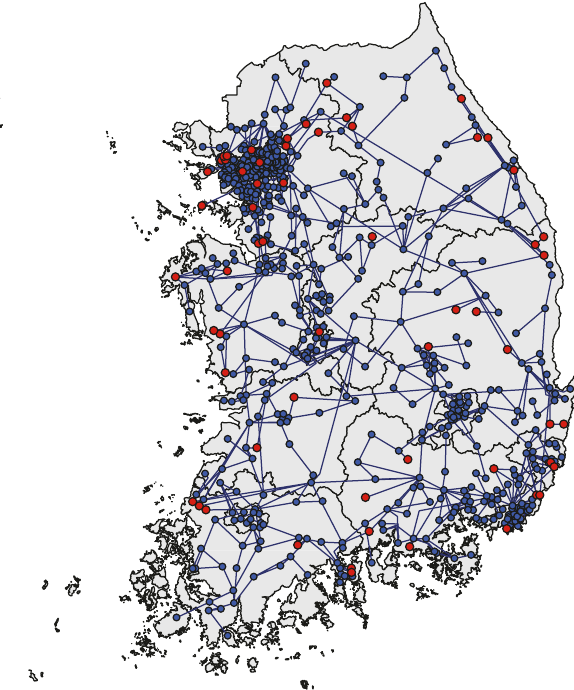
Figure 1: Map of the 2013 South Korean power grid. This map shows the connectivity of major power grid infrastructure in mainland Korea, that is, power plants (red circles), high-voltage transmission substations (dark blue circles), and power lines (dark blue lines). Transformers connect buses that are too close together to be shown in this image. For security purposes, data is simplified to only publicly available data from the Korean Power Exchange [20]. Jeju Island off the southern coast of Korea is also excluded from the image because it is not considered in the current